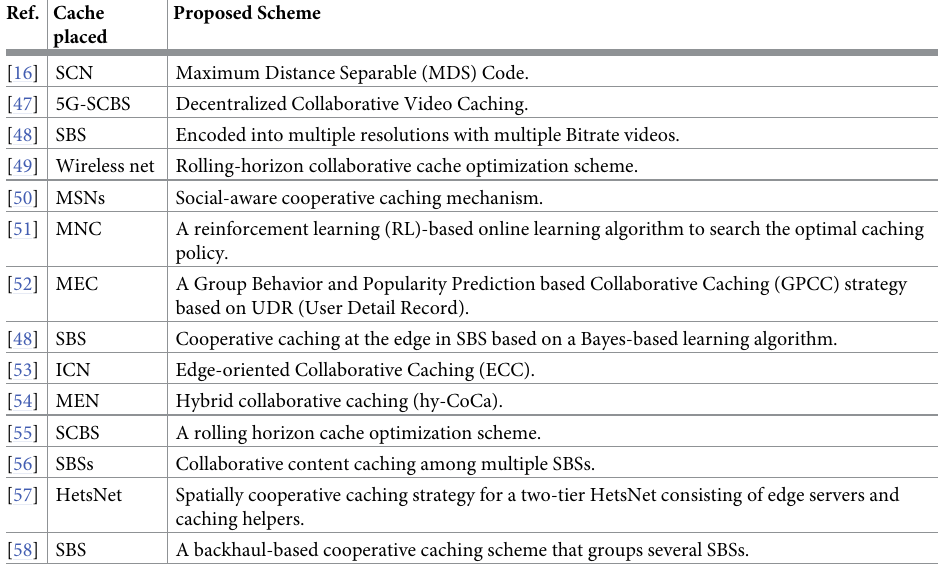
Table 2. Summary of cooperative distributed cache methods. Ref. Cache